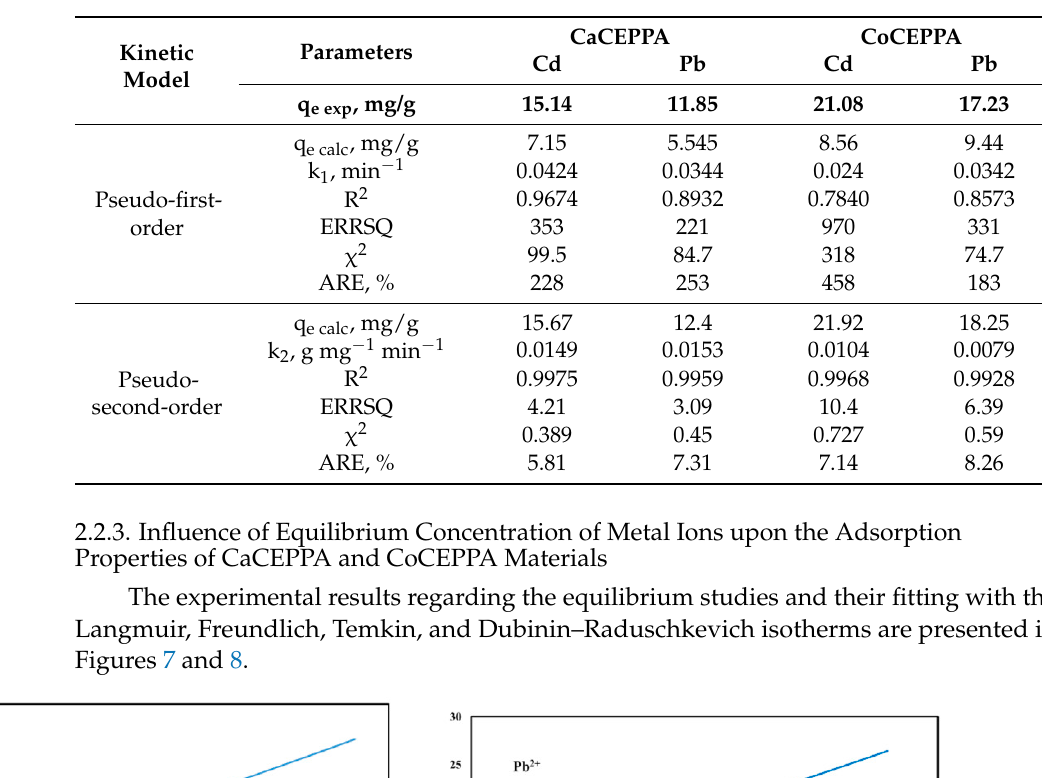
Table 1. Pseudo-first-order and pseudo-second-order kinetic parameters for Cd 2+ and Pb 2+ adsorp- tion from aqueous solutions onto CaCEPPA and CoCEPPA materials.